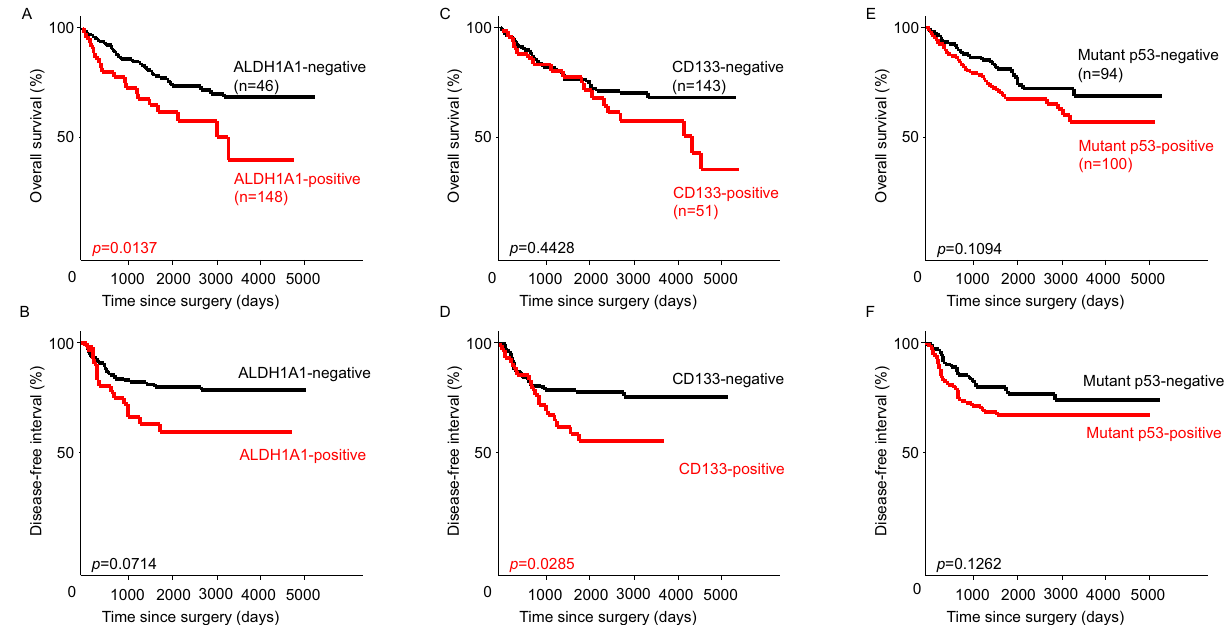
Figure 2. Kaplan–Meier curves of overall survival (OS) and disease-free interval (DFI) of ALDH1, CD133, and mutant p53. ( A ) OS curves stratified by ALDH1A1 expression. ( B ) DFI curves stratified by ALDH1A1 expression. ( C ) OS curves stratified by CD133 expression. ( D ) DFI curves stratified by CD133 expression. ( E ) OS curves stratified by mutant p53 expression. ( F ) DFI curves stratified by mutant p53